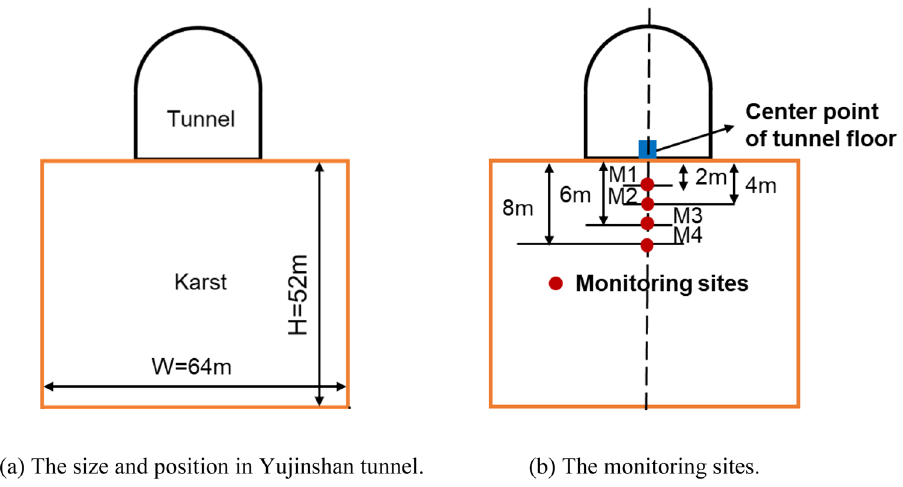
Figure 9. The numerical model and monitoring